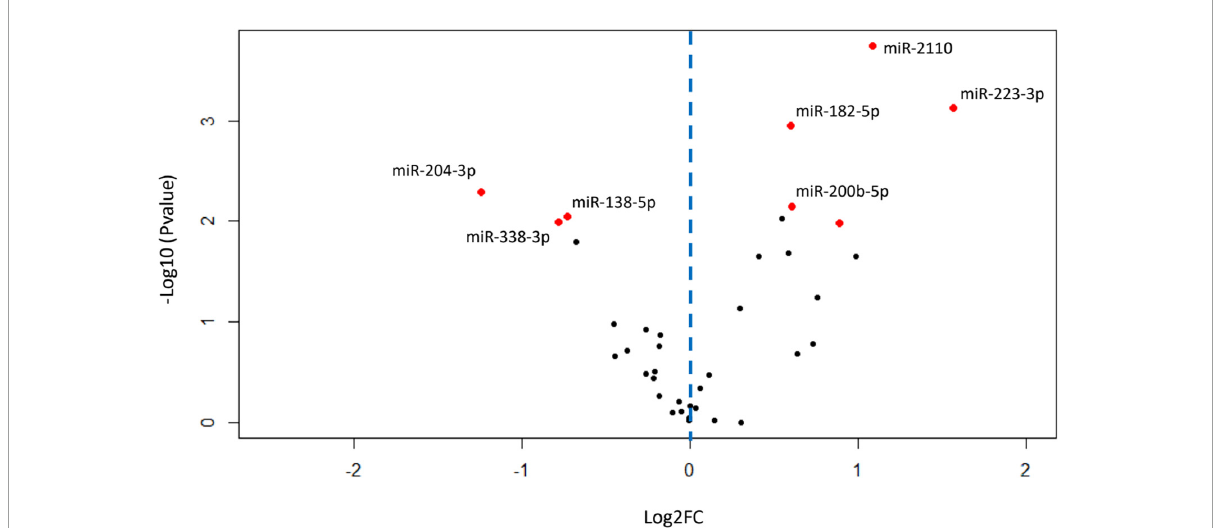
FIGURE2 Volcano plot showing relationship between P -values and expression data for differentially expressed miRNA validated by RT-qPCR. Red dots show miRNA with P -values < 0.05 after false discovery rate (FDR) correction for multiple testing. Blue dotted line represents zero Log2FC, data points to the right are upregulated in chronic obstructive pulmonary disease (COPD), and data points to the left are downregulated in COPD. FC, fold change; miRNA, microRNA; RT-qPCR, real-time quantitative PCR.